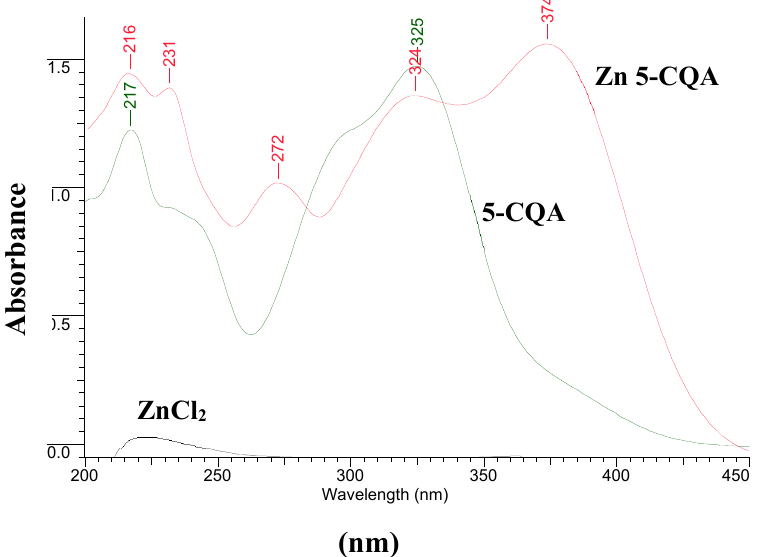
Figure 4. The ultraviolet (UV) spectra of the series of solutions prepared according to the Job’s method (0.1 mM 5-CQA and 0–0.09 mM ZnCl 2 in Tris-HCl, pH = 7.4). The lowest line showed the spectra of 0.1 mM ZnCl 2 .